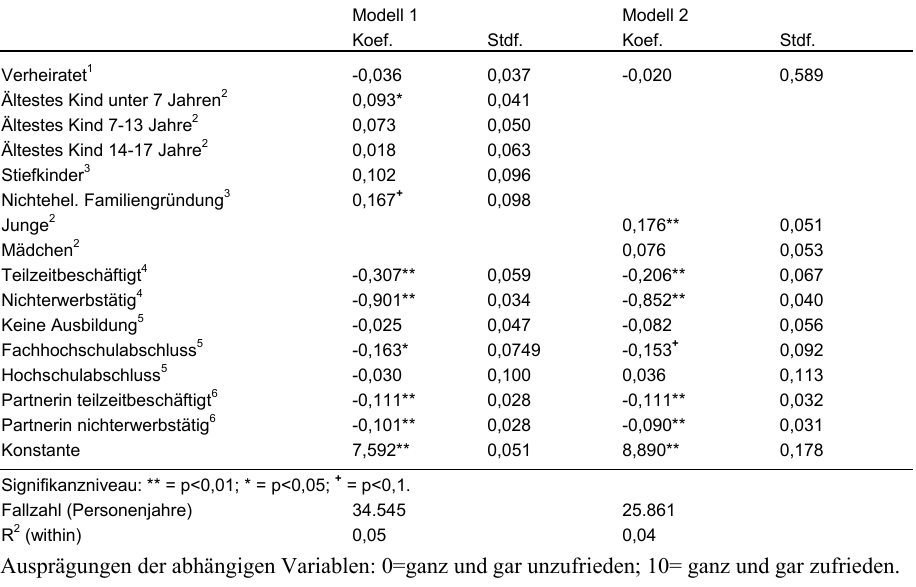
Tabelle 1 : Determinanten der Lebenszufriedenheit (Fixed Effects Regression) Modell 1 Modell 2 Koef. Stdf. Koef.